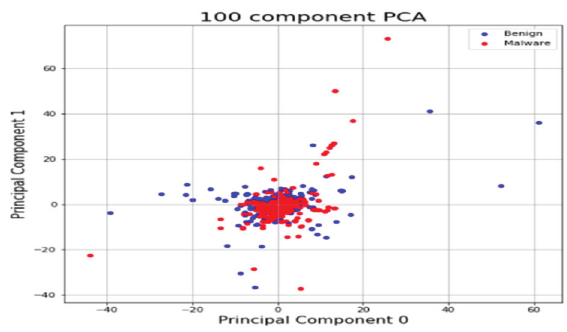
Figure 16. Feature vector distribution of Windows and Linux binary.